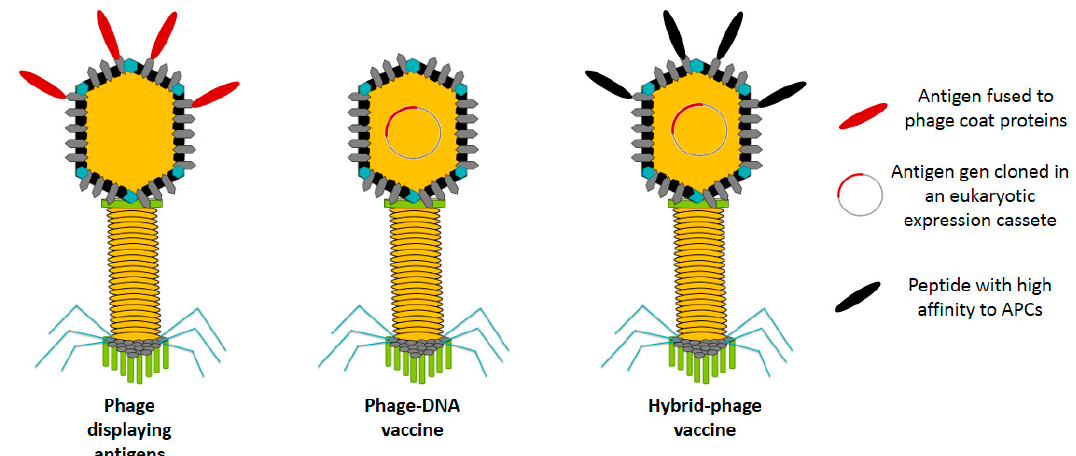
Figure 1. Simplified schematic representations of the three types of phage-based antigen delivery systems currently reported. An antigen delivery system based on a hybrid phage-DNA vaccine combines the concepts of the other two systems. It is based on a phage displaying on its surface peptides with specific affinity towards antigen presenting cells (APCs) and at the same time, it harbors a DNA plasmid encoding the therapeutic antigen in a eukaryotic expression cassette.